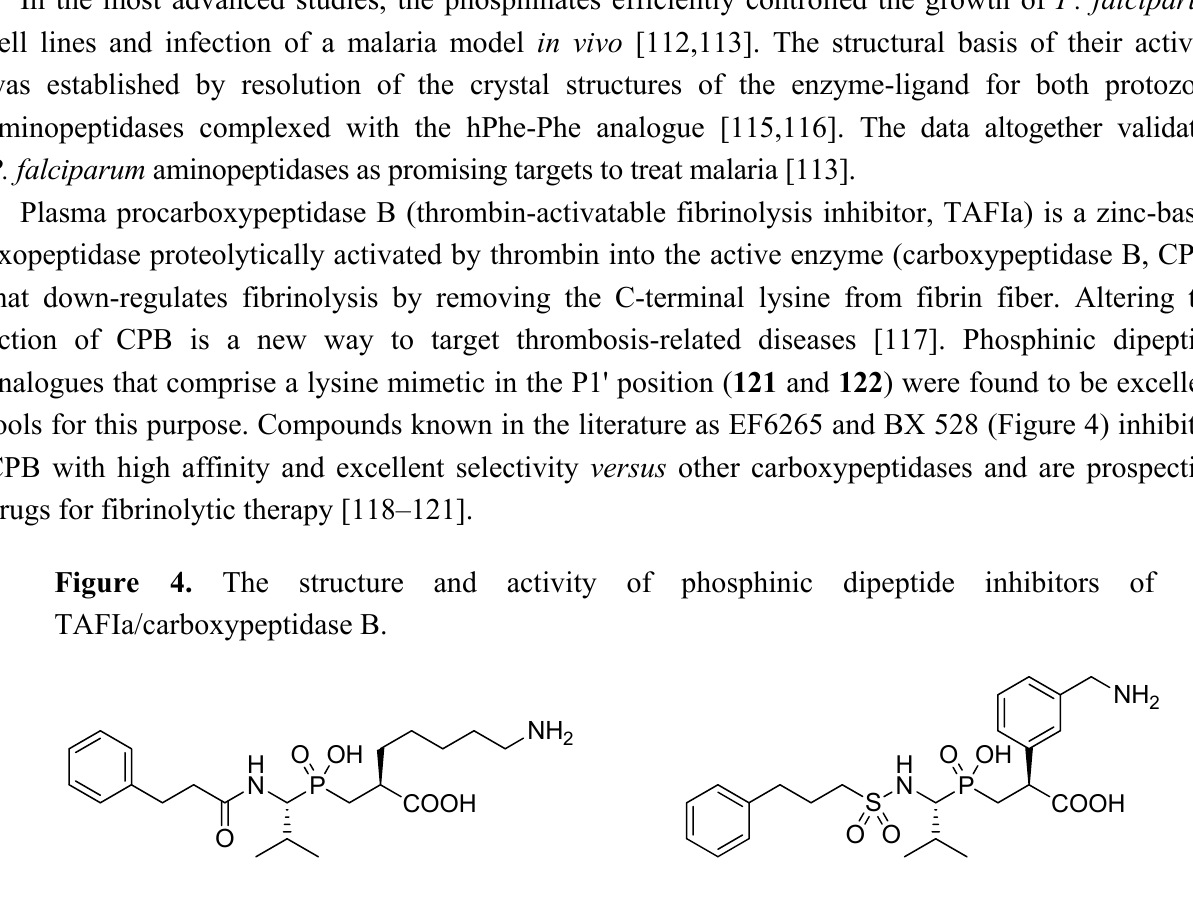
Figure 3. The structure and activity of hPhe  [P(O)(OH)CH